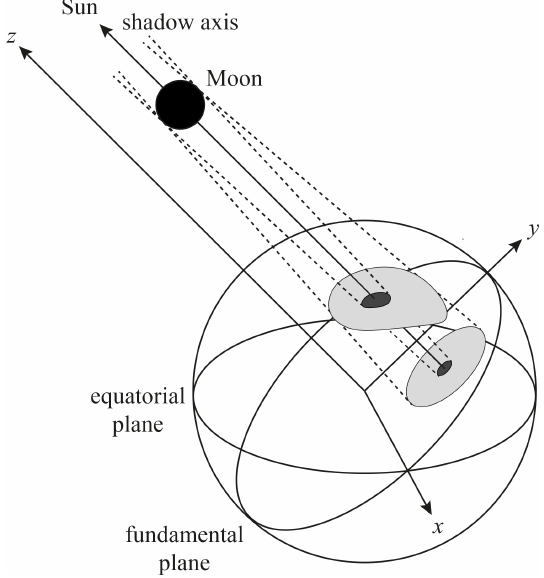
Figure 8. Sketch of the fundamental reference frame (not to scale). The Moon shadow that is cast on the Earth’s surface has a com- plicated shape, but the shadow on any plane parallel to the fun- damental plane ( z = 0) has a circular shape, and the local eclipse circumstances solely depend on the distance to the shadow